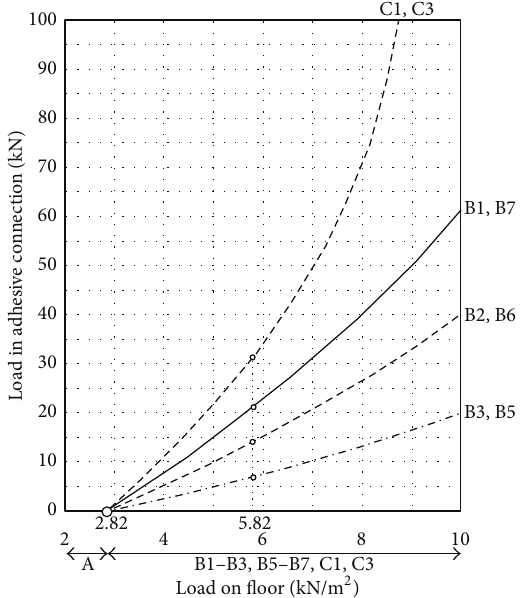
Figure 7: Anchor stress. 𝐿 = 12 m. 𝐻 = 𝐿/33 . 𝛼 0 = 26.57 ∘ .